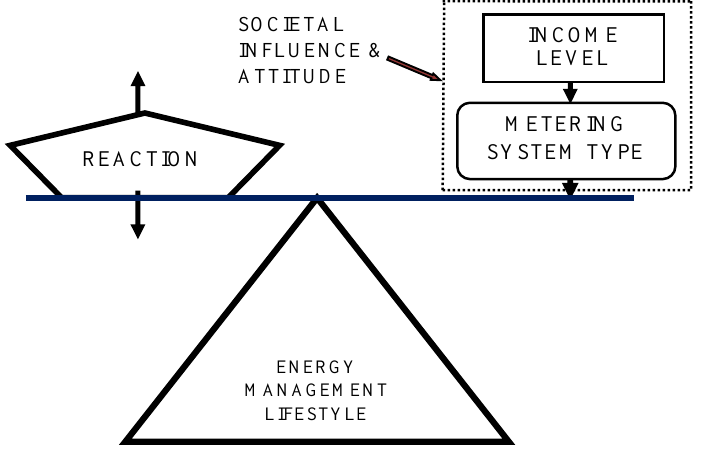
Fig. 3. Anthropogenic energy management